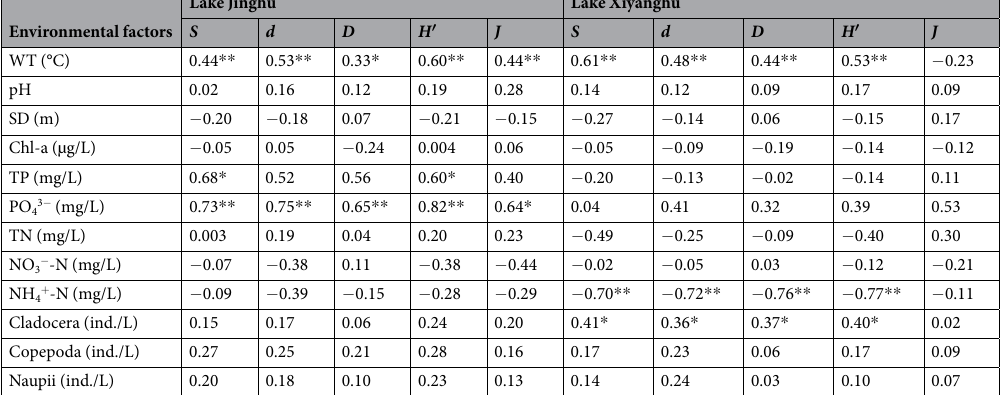
Table 3. Pearson moment correlation between taxonomic indices (species numbers = S , Simpson index = d , Margalef index = D , Shannon-Wiener index = H ′ , Pielou evenness index = J ) and each environmental factor (WT = water temperature, SD = Secchi disc, Chl- a = Chlorophyll- a ) in Lake Jinghu and Lake Xiyanghu. ( * p < 0.05; ** p < 0.01).